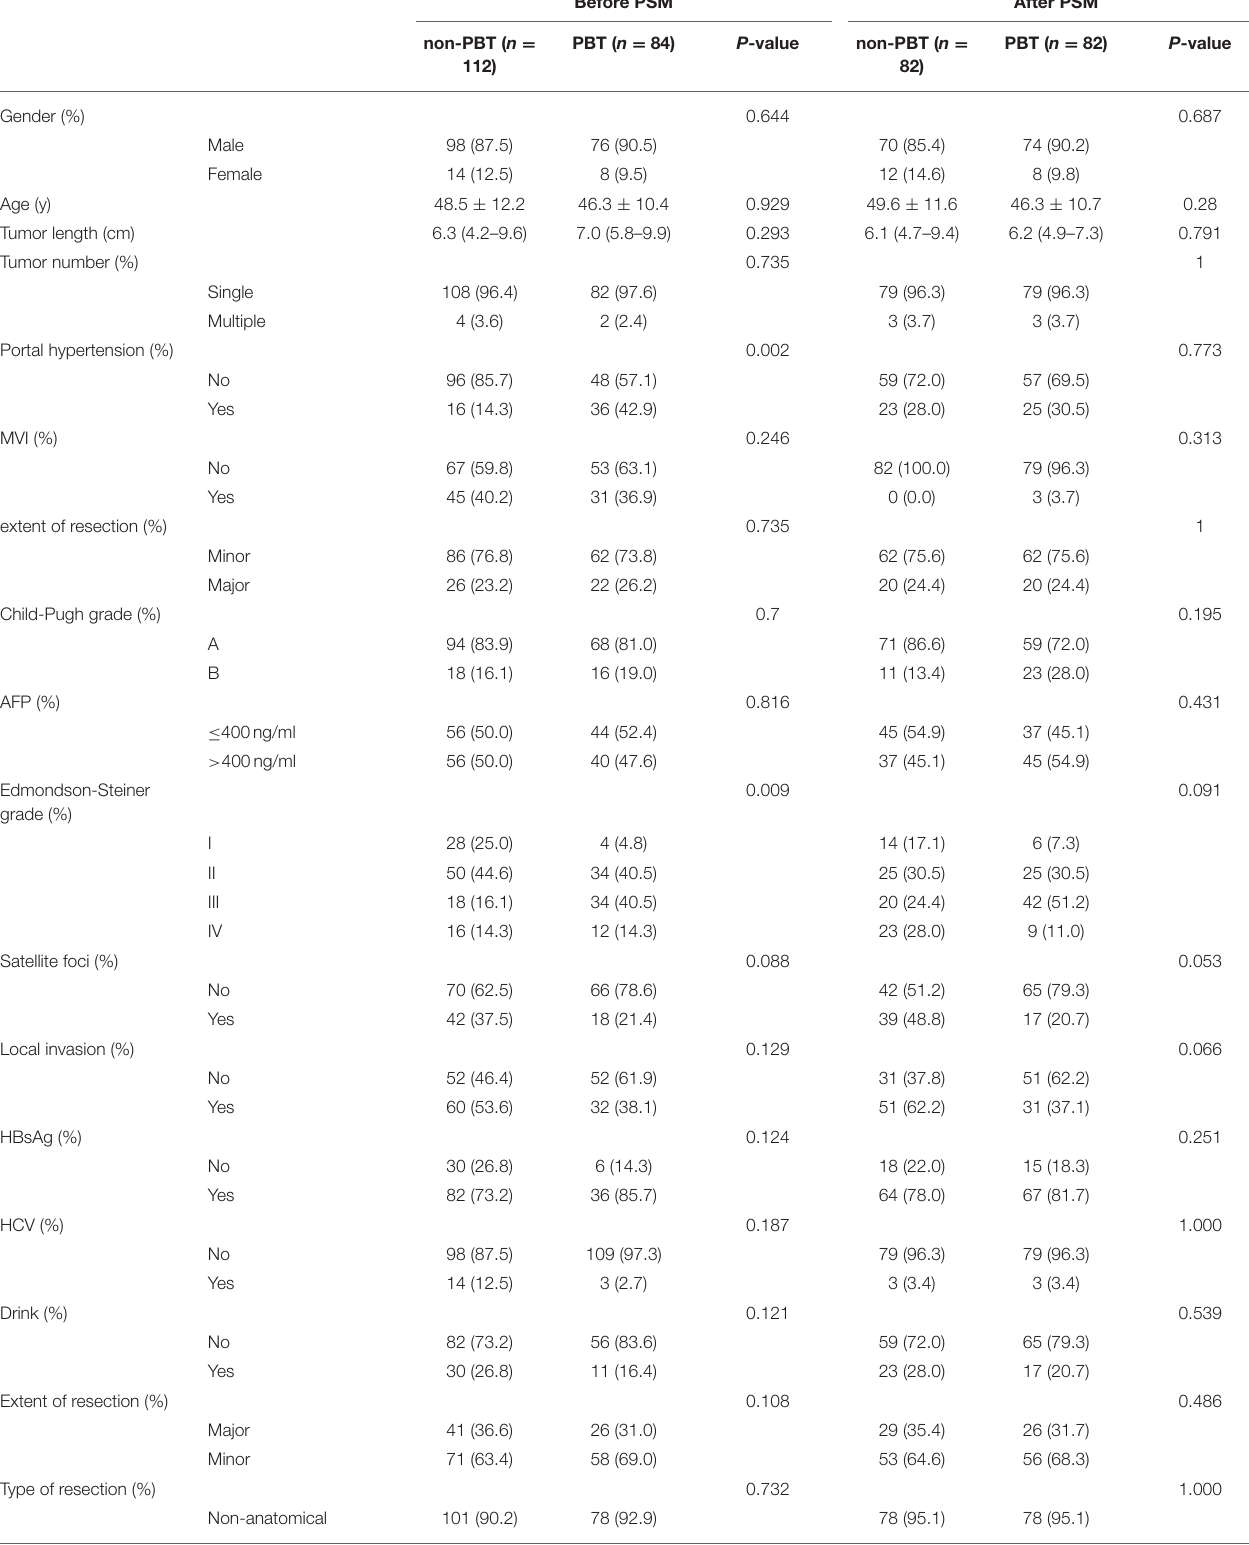
TABLE 1 | Clinicopathologic characteristics of rHCC patients with early-stage (BCLC stage A)